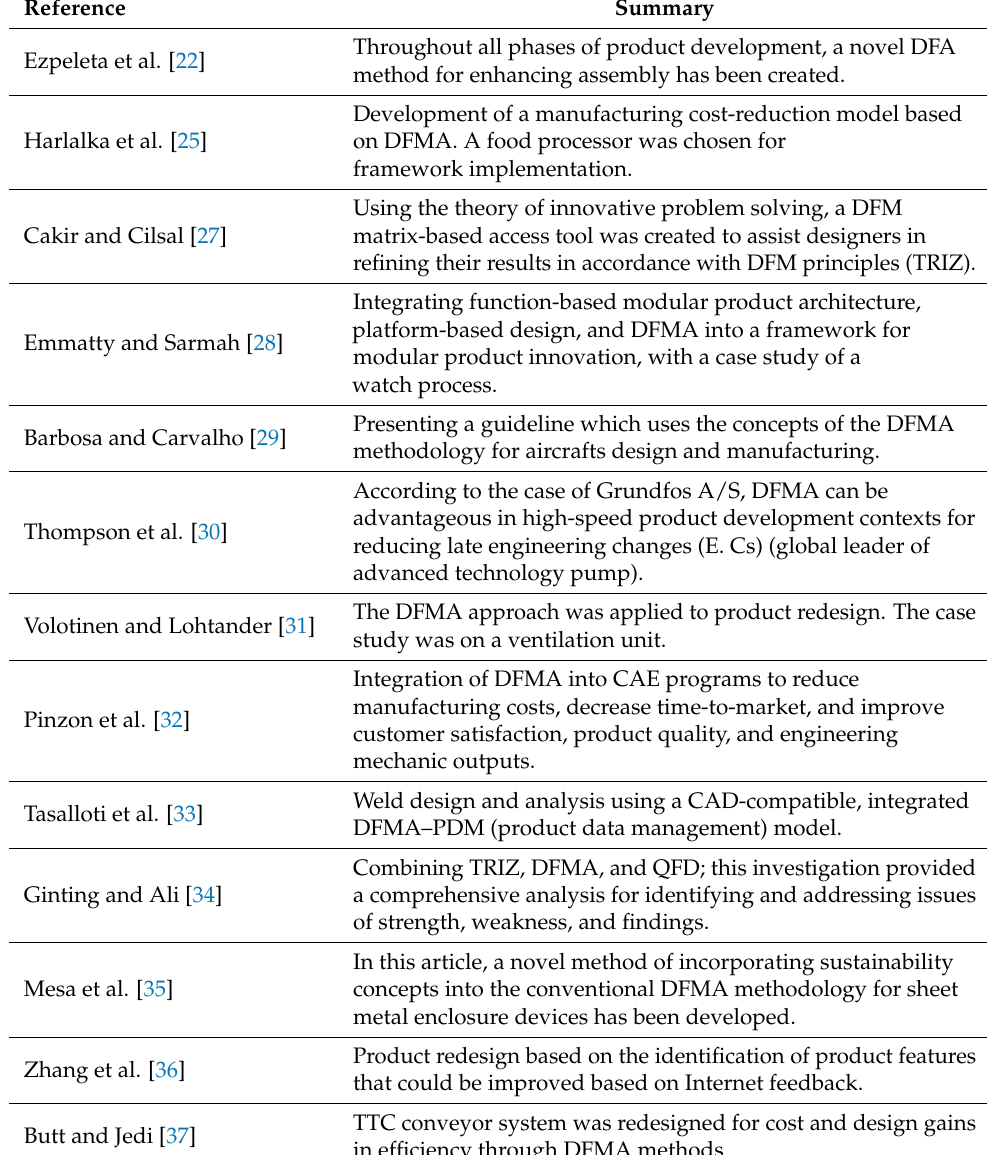
Table 1. Summary of several studies on the DFMA